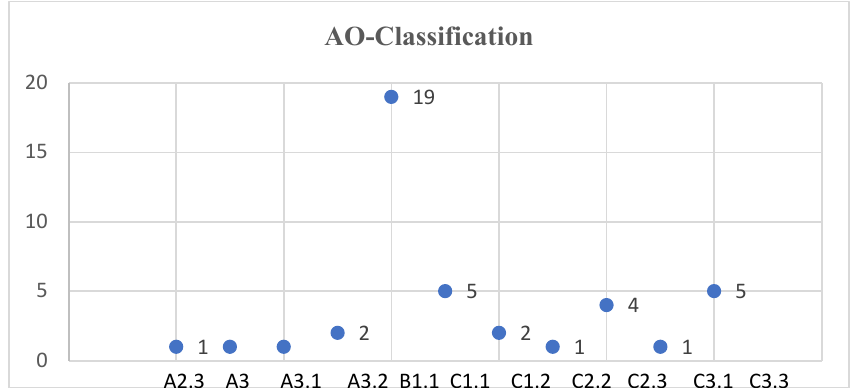
Figure 2. Distribution of fracture type according to AO-Classification. Table 3. Inter-observer reliability of radiographic assessment of humerus fracture classification be-